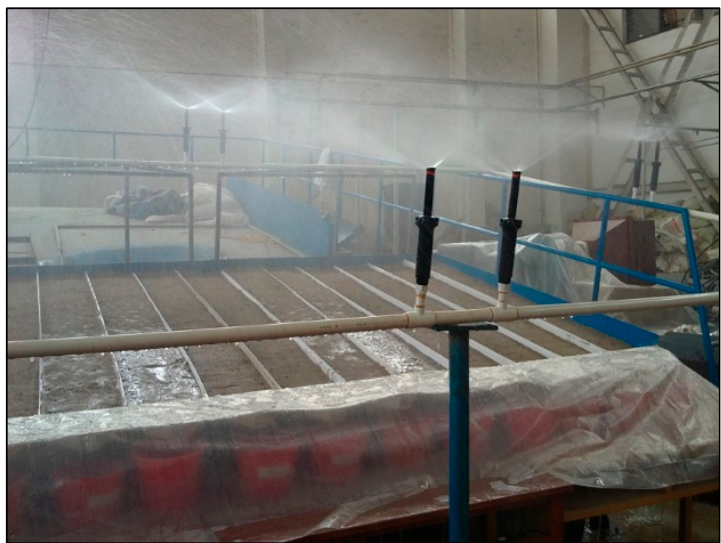
Figure 1. Experimental apparatus for the simulation of sandy slope and rainfall.